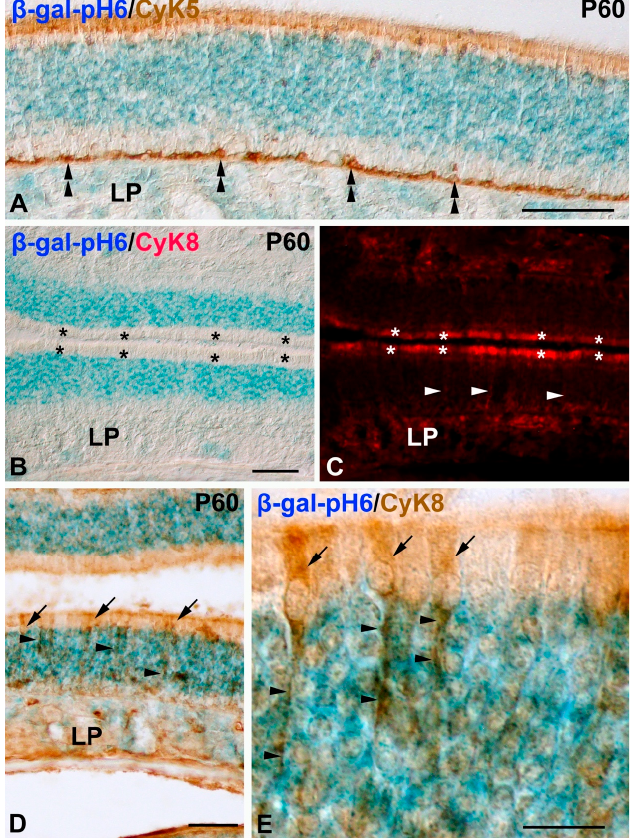
Figure 4. Relationship between β -gal-pH6 histochemical staining and markers of horizontal basal ( A ) and supporting cells ( B – E ) in the postnatal olfactory mouse mucosa. Cryosections of the P60 olfactory epithelium were doubly labeled with β -gal-pH6 histochemistry and antibodies against CyK5 ( A ) or CyK8 ( B – E ). ( A ) CyK5-immunoreactive horizontal basal cells were located in the basal surface of the olfactory epithelium (double arrowhead) in a region negative for the β -gal-pH6 staining. ( B – E ) CyK8 immunoreactive supporting cell bodies were always located apically to the β -gal-pH6 labeling (asterisks in ( B , C ); arrows in ( D , E )). CyK8 immunoreactive fine processes from supporting cells were observed spanning the full extent of the epithelium (arrowheads in ( C – E )). LP, lamina propria; OE, olfactory epithelium. Scale bars: 100 µ m in ( A – D ); 15 µ m in ( E